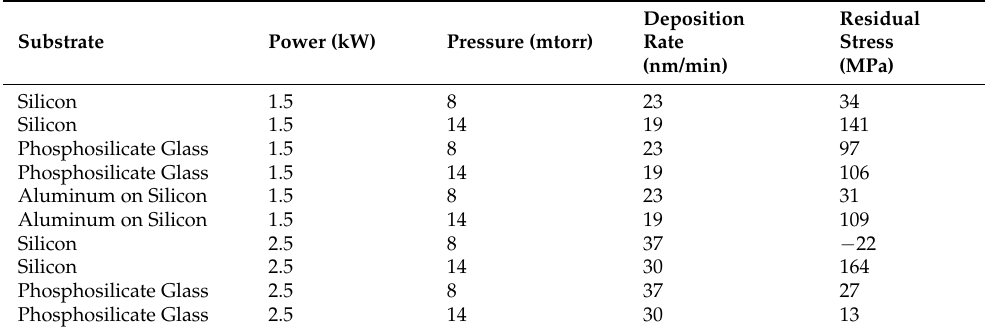
Table 14. Residual Stresses of Sputter-Deposited Silicon Layers on Various Substrates and Processing Conditions. All Depositions were performed at Room Temperature [130].